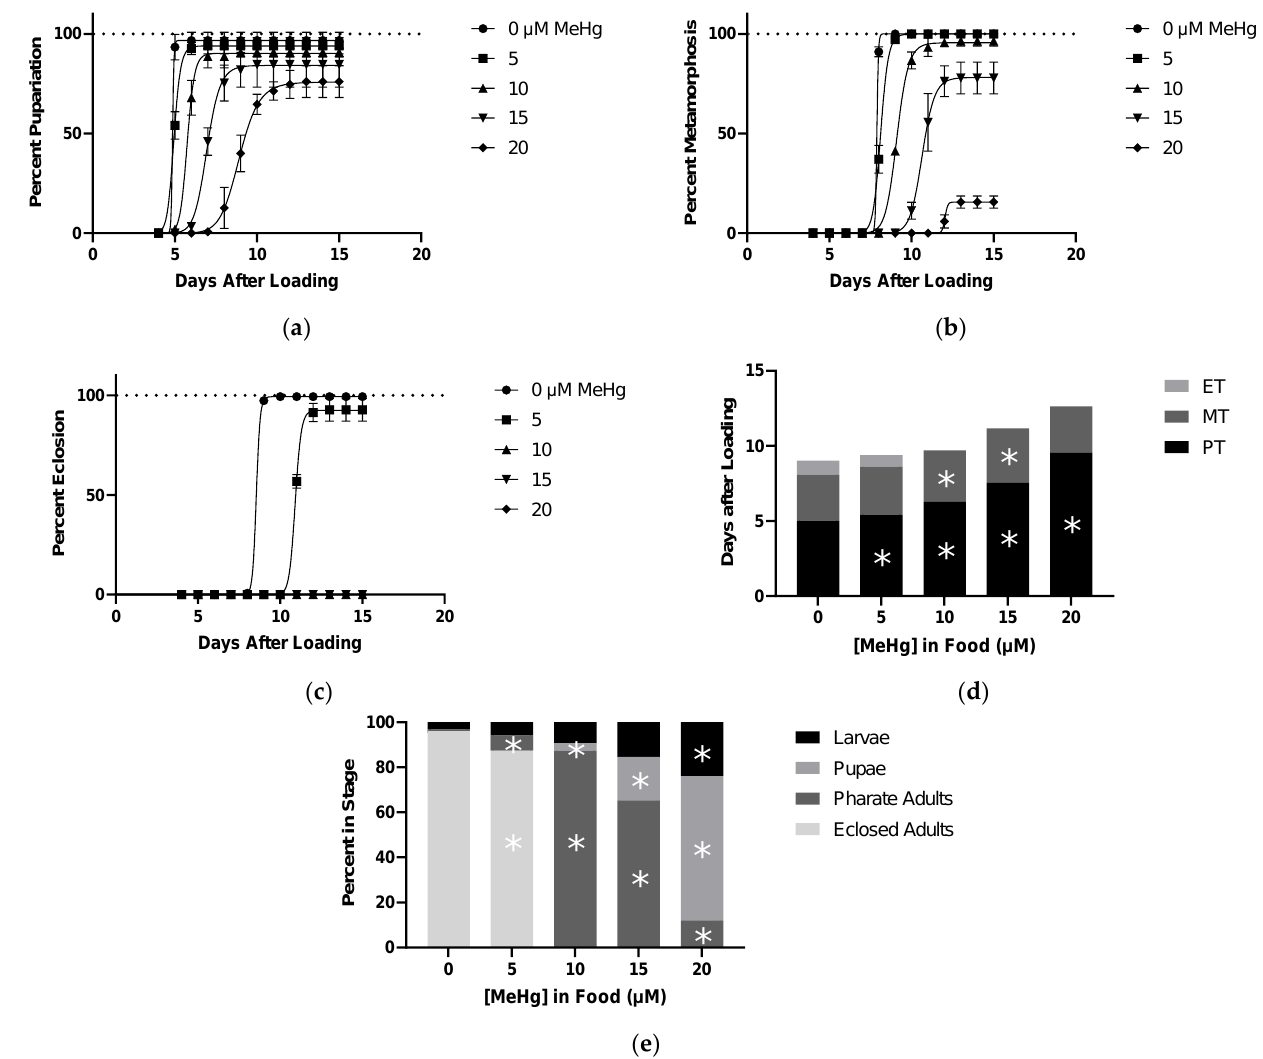
Figure 1. Effects of MeHg on Developmental Time Course. All data from same experiment using CS larvae dosed with indicated concentrations of MeHg in food. ( a ) Pupariation: pupae formation rates of larvae after being loaded onto food. ( b ) Pupa Metamorphosis: pharate adult formation rates of pupae standardized to total pupae formed. ( c ) Pharate Adult Eclosion: rate of eclosion standardized to total number of individuals completing metamorphosis. ( d ) Developmental Timing: representation of time spent in each stage derived from data shown in Figure 1a – c. This allows for accounting of delays seen in later stages caused by carryover of pupariation delays. ( e ) Developmental Endpoints: representation of individuals in each stage at the defined endpoint of 15 days from 1a – c. Individuals that are not eclosed adults correspond to a lethality during development. (* p < 0.05 compared to 0 µM, two-way ANOVA).